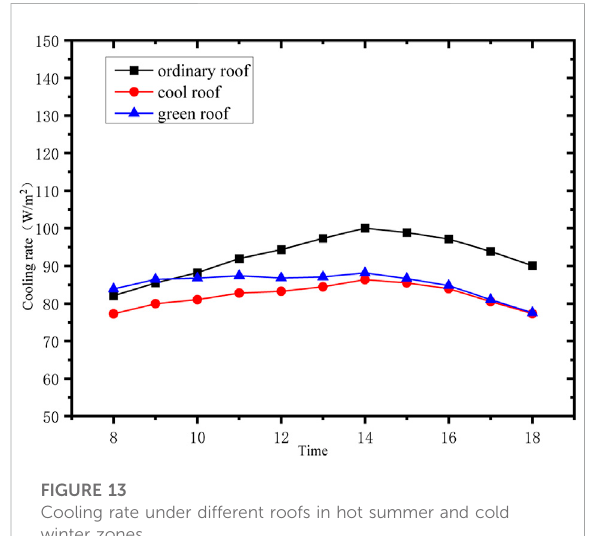
FIGURE 13 Cooling rate under different roofs in hot summer and cold winter zones.